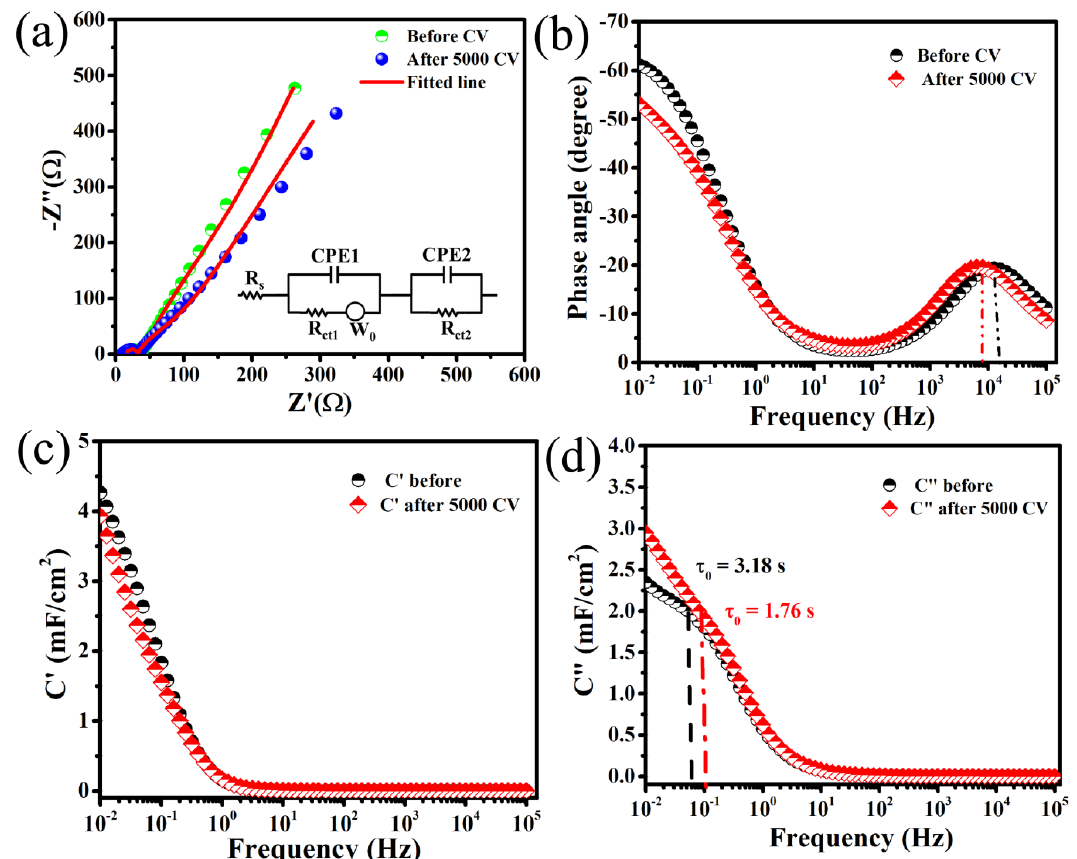
Figure 4. ( a ) Electrochemical imprudence spectroscopy (EIS) before and after 5000 cycles with equivalent circuit (inset), ( b ) Bode plots, ( c ) Real part of capacitance (C ′ ) vs. frequency and ( d ) Imaginary part of capacitance (C ″ ) vs. frequency of FSC based on polymer electrolyte gel and Mn/MnO x @Graphite-foil electrodes.